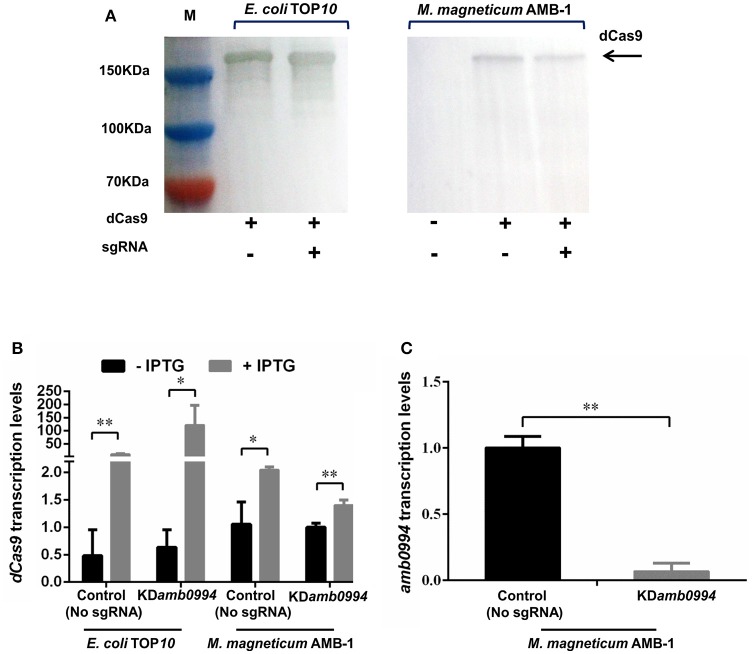
CRISPRi efficiently represses the amb0994 gene transcription. (A) Western blot detection of dCas9 after SDS-PAGE with whole cell samples from experiment. The M represents the positions on the gel of the molecular mass markers (from top to bottom: 150, 100, and 70 kDa). (B)
dCas9 transcription levels of the control (plasmid without sgRNA) and test strains in E. coli and M. magneticum AMB-1 cells (N = 3 per strain) were determined. The error bars represent the standard deviation of samples. (C) The relative expression levels of amb0994 in the KDamb0994 compared to control strains without sgRNA. The levels of transcription were calculated relative to the housekeeping gene rpoD (N = 9 per strain). The error bars represent the standard deviation of samples. *P < 0.05, **P < 0.01.